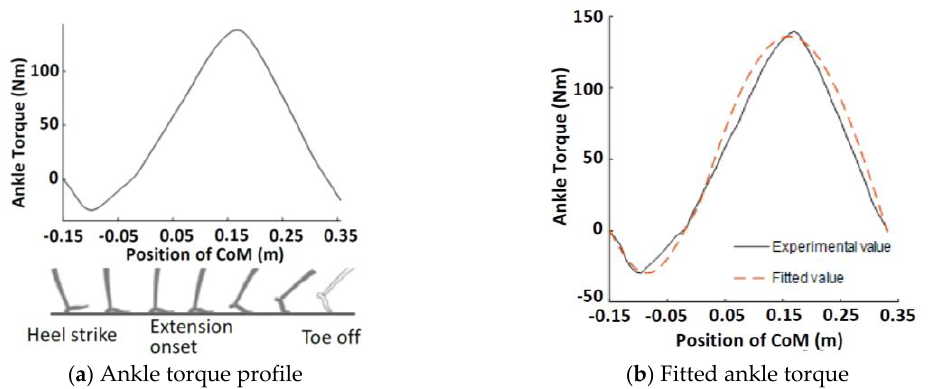
Figure 3. The relationship between the position of the center of mass (CoM) and ankle torque. According to model (2) and (3), the state of CoM ([ x ,